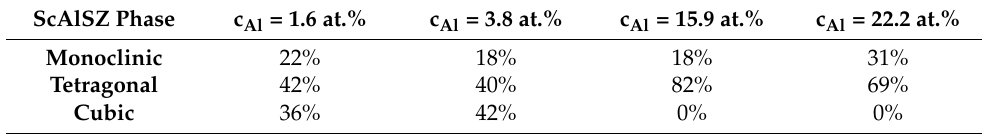
Table 2. The ratio of monoclinic, tetragonal, and cubic phases of deposited ScAlSZ thin films. ScAlSZ Phase